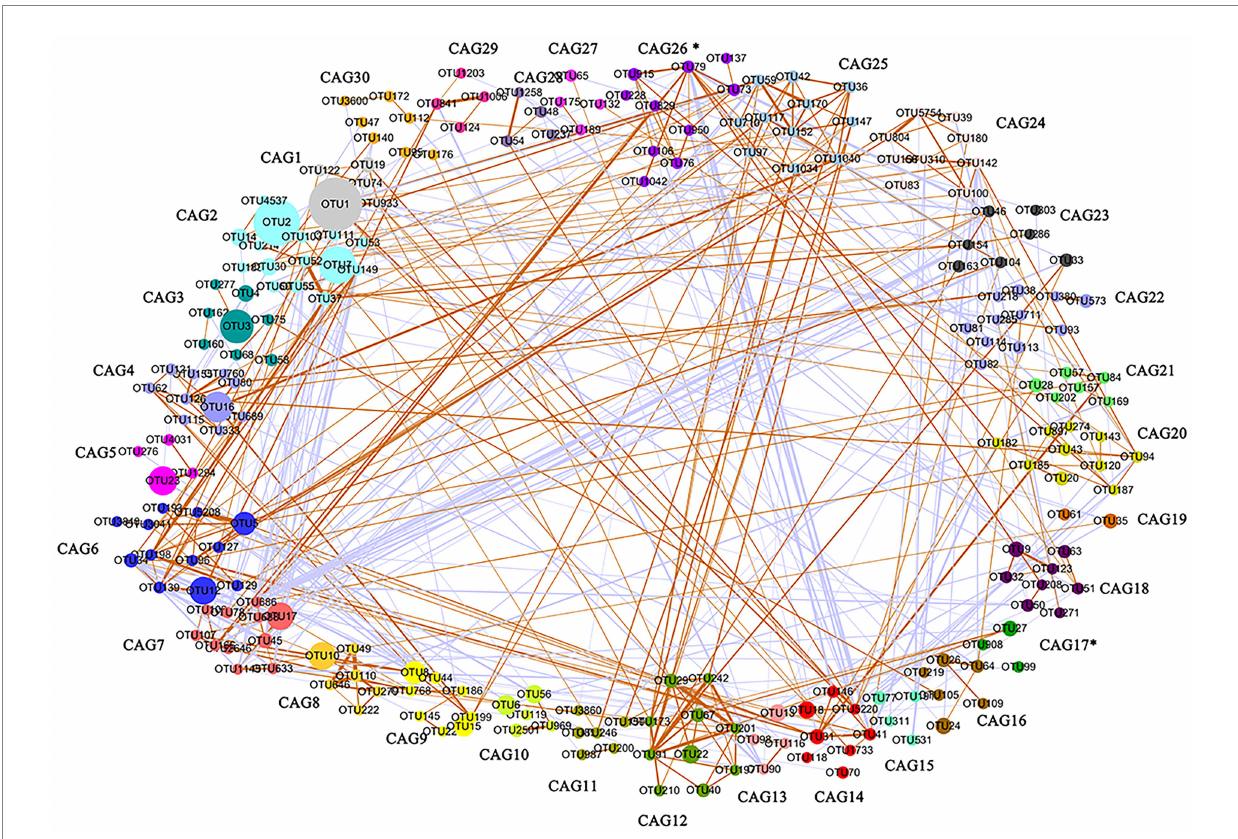
FIGURE 3 Co-abundance groups (CAG) in cecal microbiota based on the relative OTU abundance in Qiandongnan Xiaoxiang chickens at 160 ± 3 days of age ( n = 24). A total of 261 OTUs were clustered into 30 CAGs using permutational multivariate analysis of variance. Asterisks (*) represent significant differences of relative OTU abundance in CAGs between high-and low-market-weight chickens. Node sizes are proportional to the average abundance of each OTU. The lines connecting two nodes represent SparCC correlations between the connected nodes with the line width representing the correlation magnitude. Brown and purple lines represent significantly positive and negative correlations between two OTUs, respectively, using an absolute value of correlation coefficient > 0.55. Unconnected nodes were